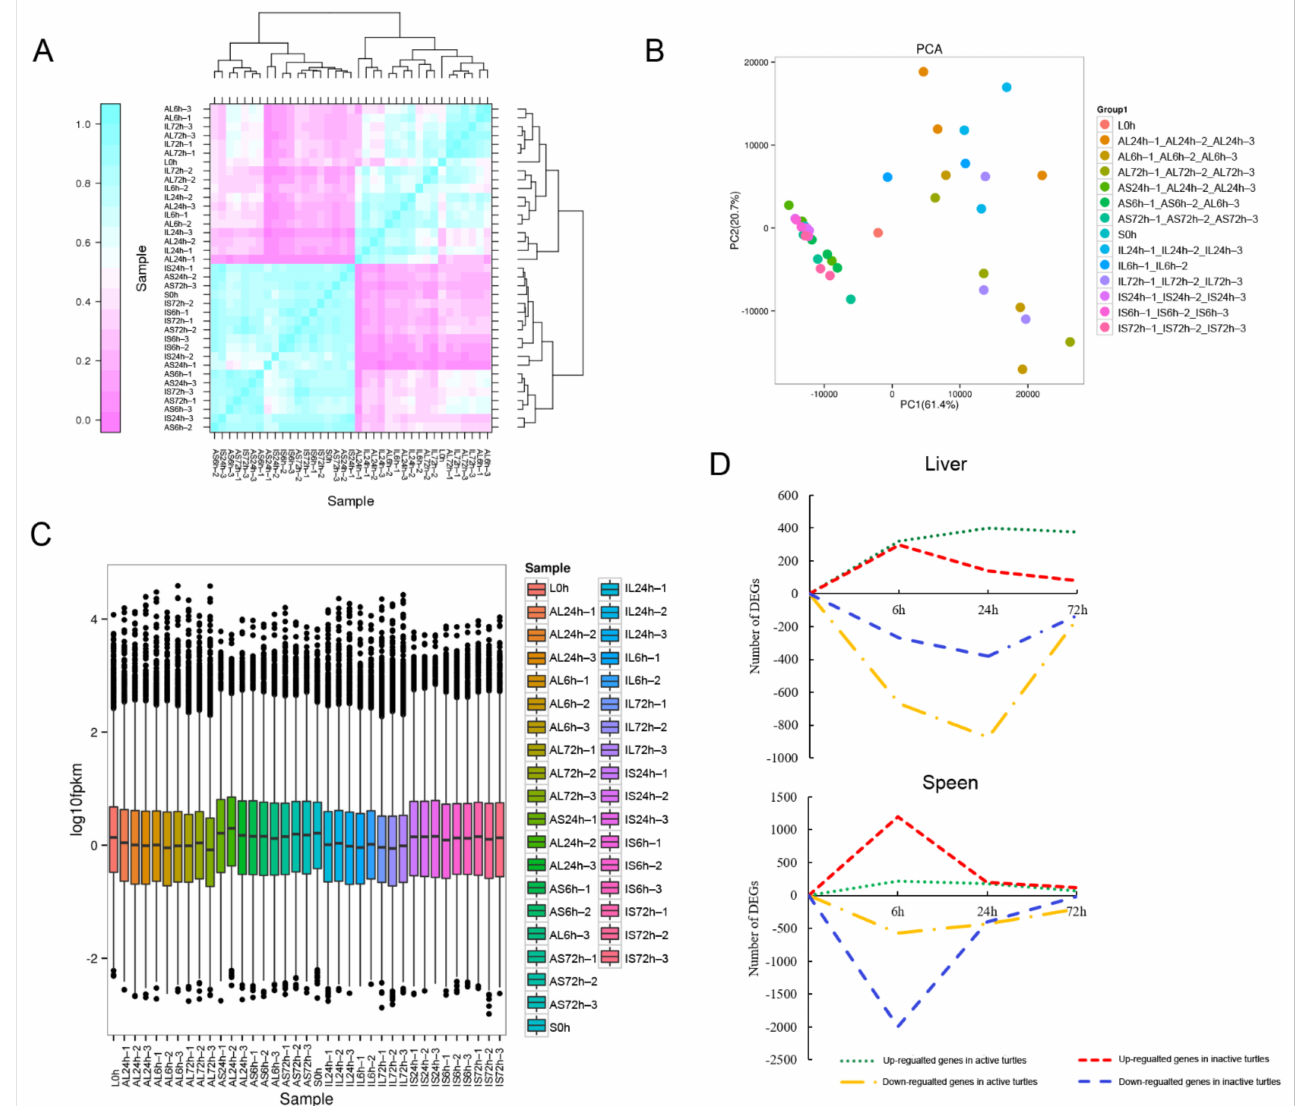
Figure 2. Transcriptional relationship between samples and the overall gene expression profiles. ( A ) Heatmap of correlation value (R square) of 37 libraries from liver or spleen samples. ( B ) Principal component analysis based on all of the expressed genes, showing 14 distinct groups of samples. ( C ) The dispersion degree of the gene expression level in a single liver or spleen sample. ( D ) The significantly up-regulated and down-regulated DEGs identified in livers or spleens from active and inactive turtles at 6, 24, and 72 hpi compared to the